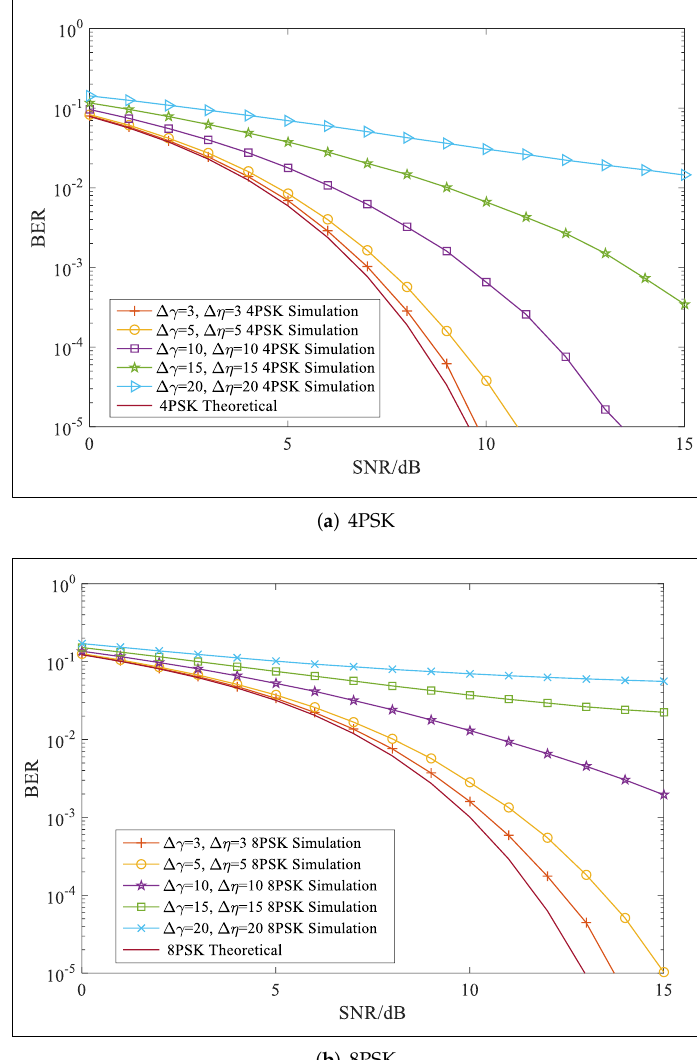
Figure 9. BER performance with PS errors ( ∆ γ , ∆ η ) .